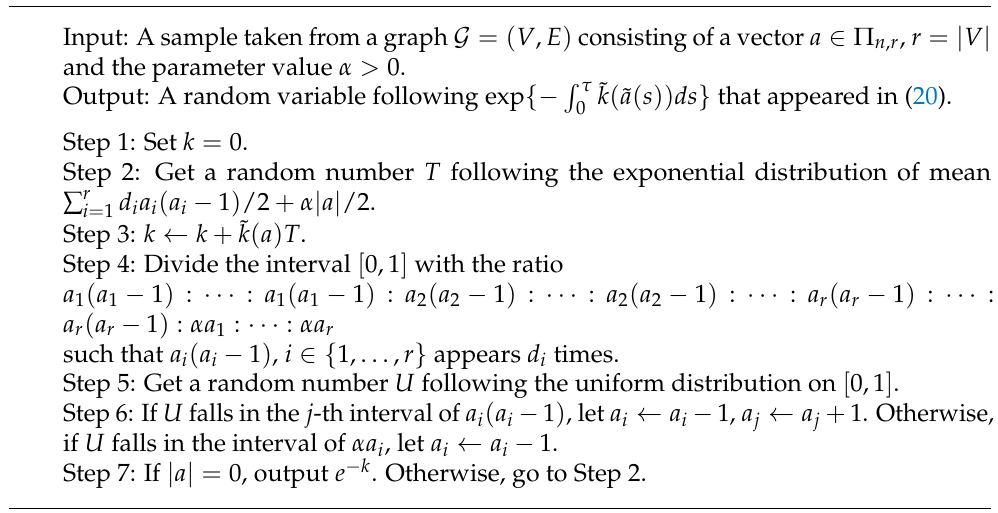
Algorithm 2 Estimating the sample probability, or the marginal